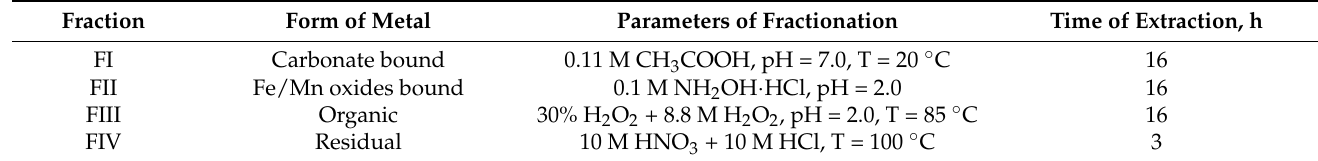
Table 3. Method of metal speciation of heavy metals in sewage sludge